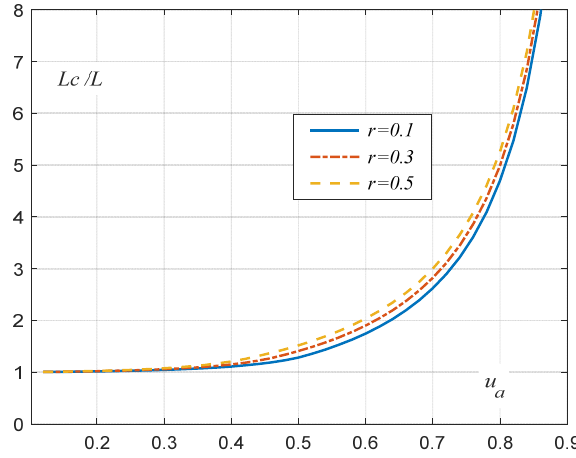
Figure 13. Relative inductance of the circuit as a function of load voltage amplitude and resistance. The equivalent inductance of the circuit for u a < 0.2 is close to the inductance Lc ≈ L , for u a ≈ 0.64 is equal to Lc ≈ 2 L .